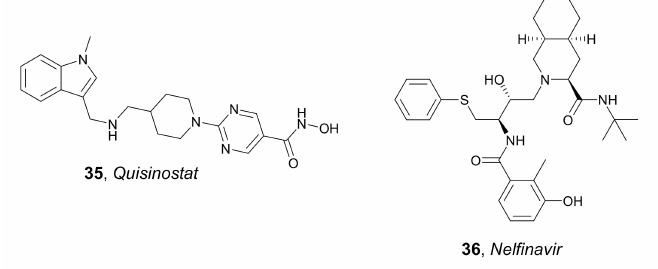
Figure 17. Chemical structures of Quisinostat 35 and Nelfinavir 36